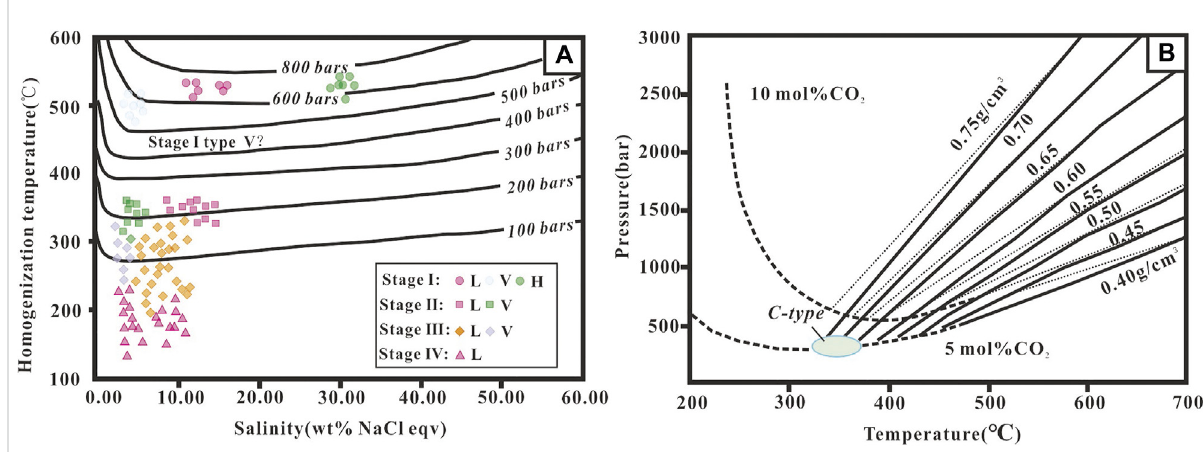
FIGURE 13 Pressure estimation for ore stage I to IV fl uid inclusions. (A) Fluid inclusion assemblages from stages I to III were trapped under boiling conditions, and isobar was calculated from the equations of Driesner and Heinrich (2007). (B) Isochrones for fl uid of 4 wt% NaCl, 5 mol% CO 2 and 10 mol% CO 2 . The solid lines mark the solvi for fl uids in the system H 2 O (6 wt%) – NaCl – CO 2 (5 – 10 mol% CO 2 ; Gehrig et al., 1986). Data for the C-type fl uid inclusions plot in the oval fi eld, indicating trapping pressures of < 500